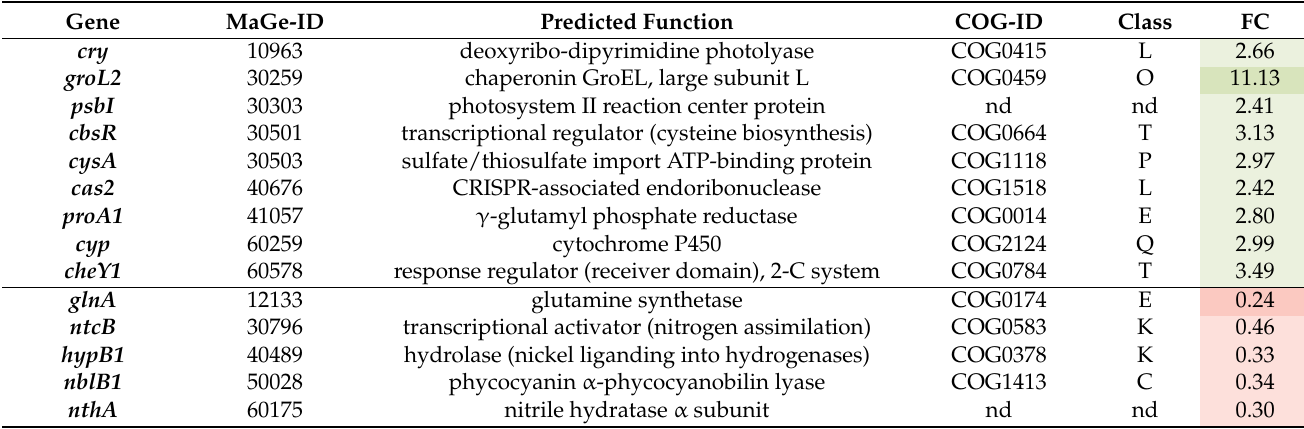
Table 4. Irradiation-induced and repressed genes of known function in P6 but not in